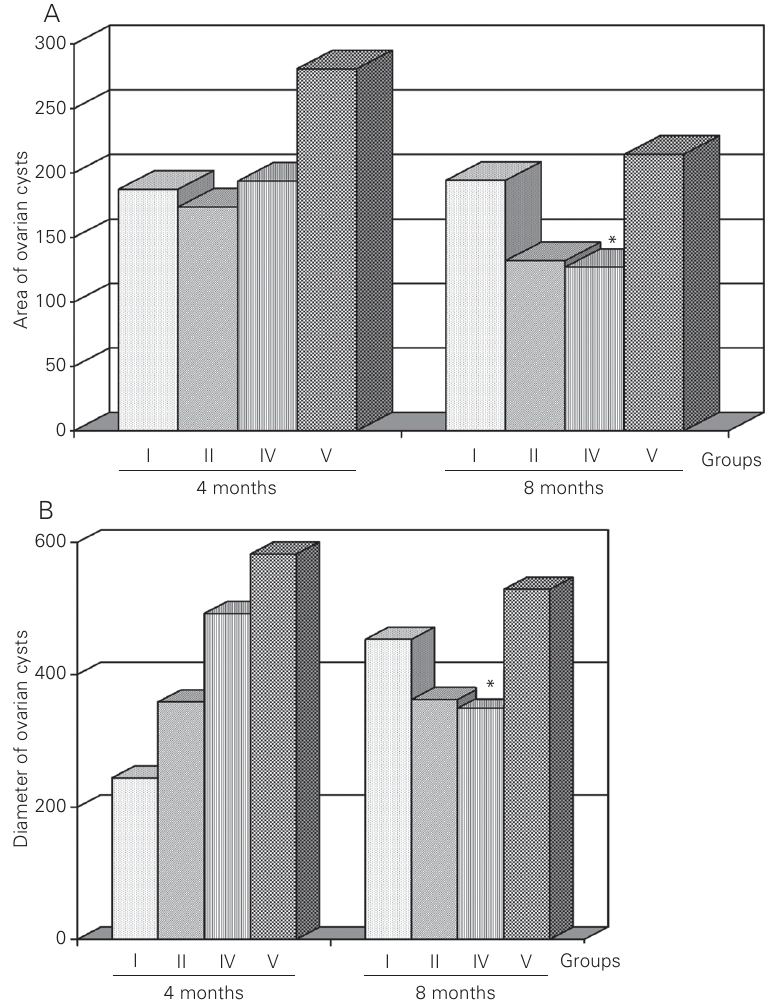
Figure 3. Area (A) and diameters (B) of the ovarian cysts in the right ovary at 4 months and in the left ovary at 8 months before and after melatonin or placebo administration. Group I: pinealectomized ovariectomized melatonin-treated group; group II: pinealectomized ovari- ectomized placebo-treated group; group IV: continuous light ovariectomized melatonin- treated group; group V: continuous light ovariectomized placebo-treated group. *P < 0.05 compared to 4 months (Wilcoxon nonparametric